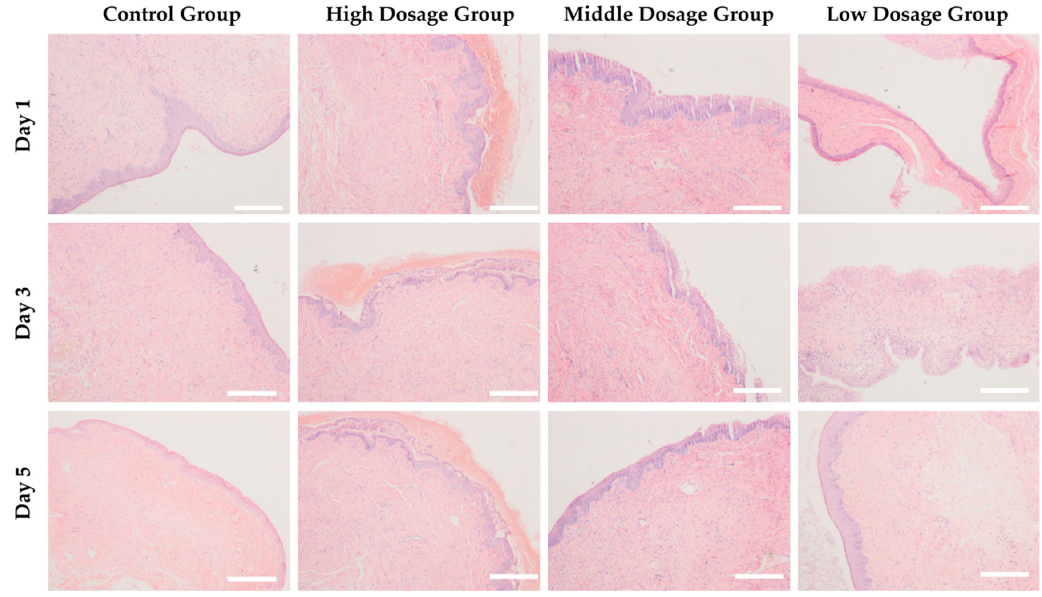
Figure 7. Hematoxylin ‐ eosin (HE) staining of Sprague ‐ Dawley (SD) rat vagina at the various indicated time after injecting hydrogels with different drug dosages into the vagina (high dosage, middle dosage, and low dosage). The CP ‐ 3 block copolymer solution at the concentration of 30 wt% was used. The volume of drug ‐ loaded copolymer solution injected into the vagina is 0.2 mL. Copolymer solutions without loading drug were injected into the vagina of SD rats as a control group, scale bar: 20 μ m.